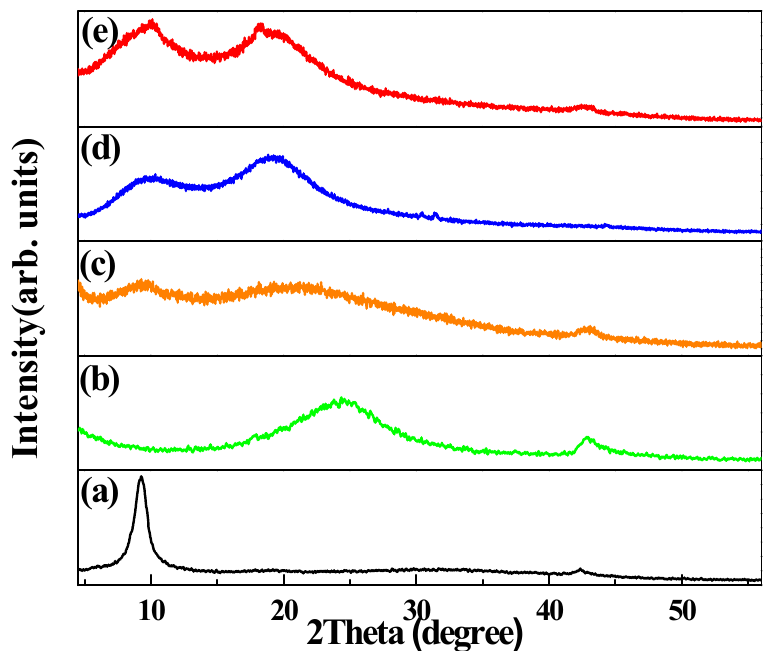
Figure 2. XRD patterns of ( a ) graphene oxide (GO), ( b ) reduced GO (RGO), ( c ) MRGO-HS, ( d ) PS beads, and ( e ) PS/GO core–shell.